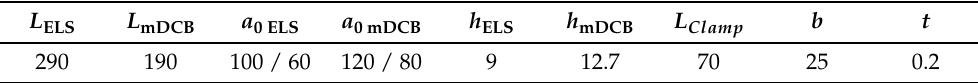
Table 6. Final recommendations for the geometrical parameters of the unified specimen. Dimensions in